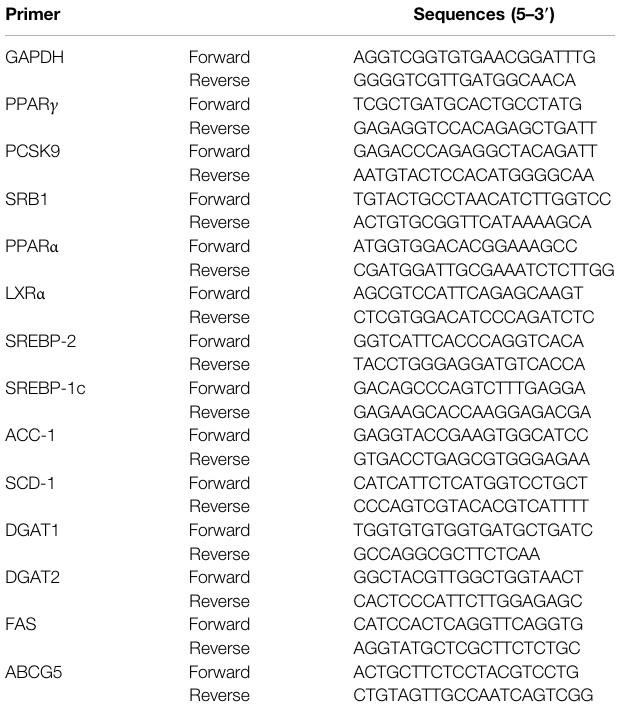
TABLE 1 | The primers used for the polymerase chain reaction (PCR) reaction.